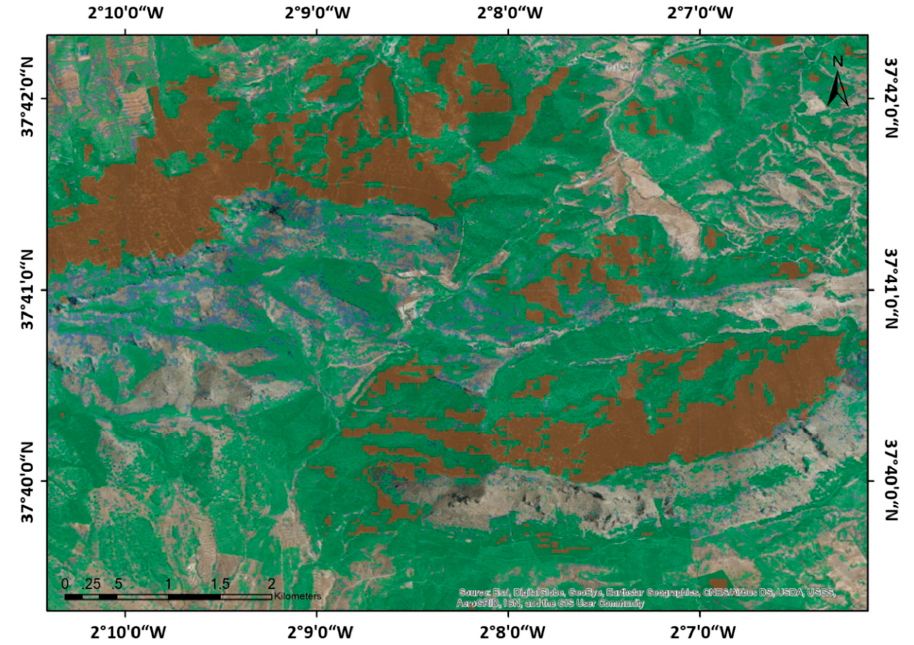
Figure 4. Example of vegetation delineation in a Mediterranean dryland. Detection of woody cover using three methods: the precipitation-sensitive dynamic threshold algorithm (green), forest mapping dataset by Hansen et al., ([3]; red) and false-positive detection by the constant threshold NDVI of 0.2 (blue).